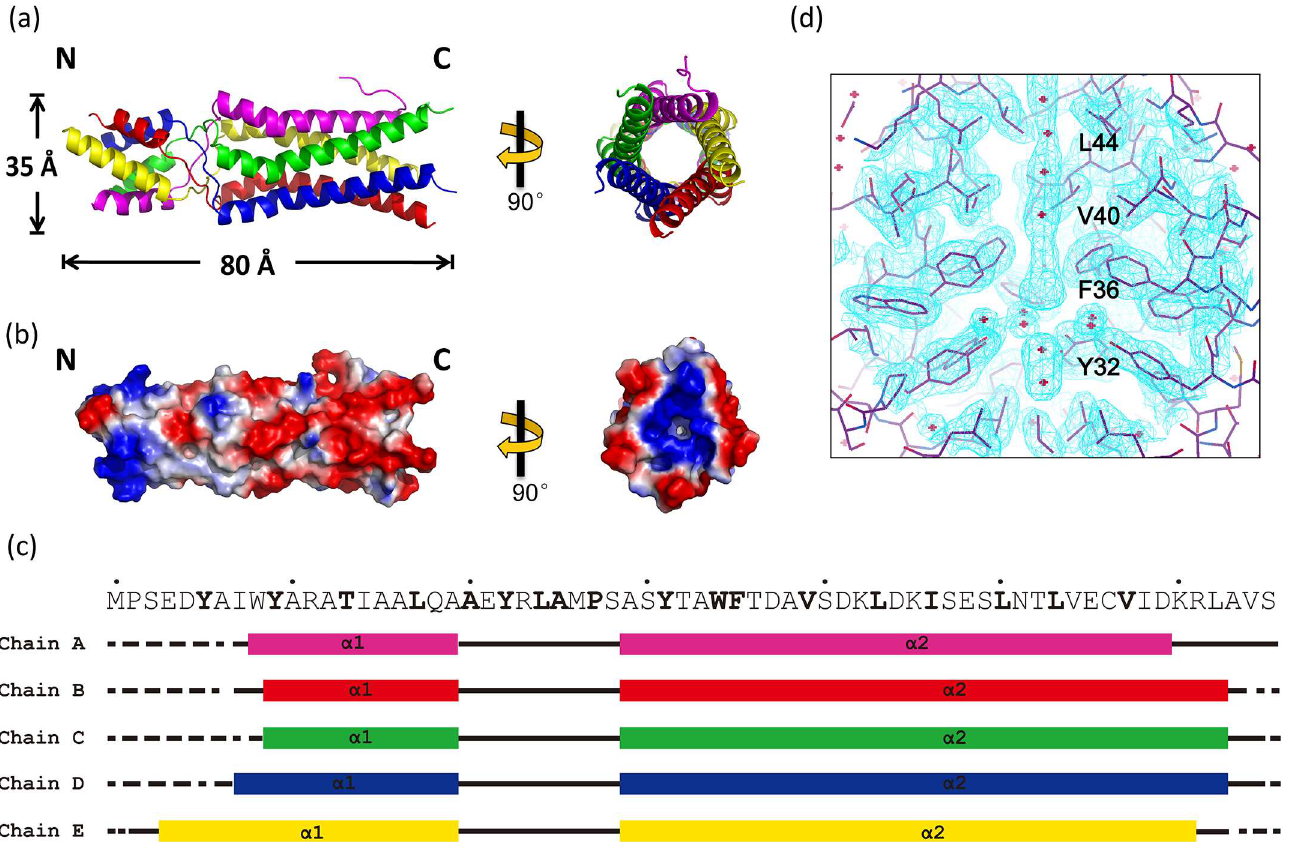
Fig 3. Crystal structure of δ (1–66). (a) Ribbondiagram. The five subunitsare shown in different colors. (b) Surface representation colored by electrostatic potential. Both a side-view(left) and a top view (right) are provided in (a) and (b). (c) Secondarystructure for the five chains in a pentamer. Bold letters highlightthe residueswith their side chains pointing to the interior of the helicalbundle. α -helicesare shown by boxes, non- structured loops are representedby black lines, and disorderedregions are shown by dotted lines. (d) An electron density map showingwater-like features insidethe